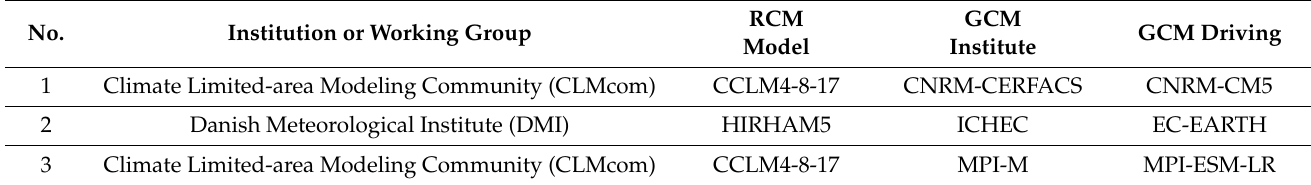
Table 1. Regional Climate Models selected in the